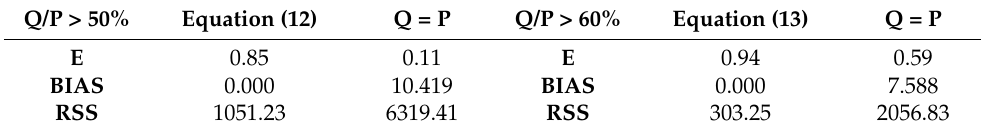
Table 9. Runoff predictive model’s comparison.